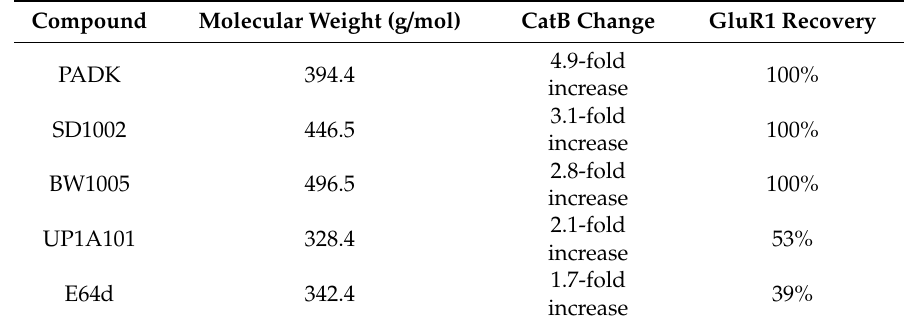
Table 1. Small-molecule cathepsin B (CatB)-enhancing compounds promote synaptic recovery.